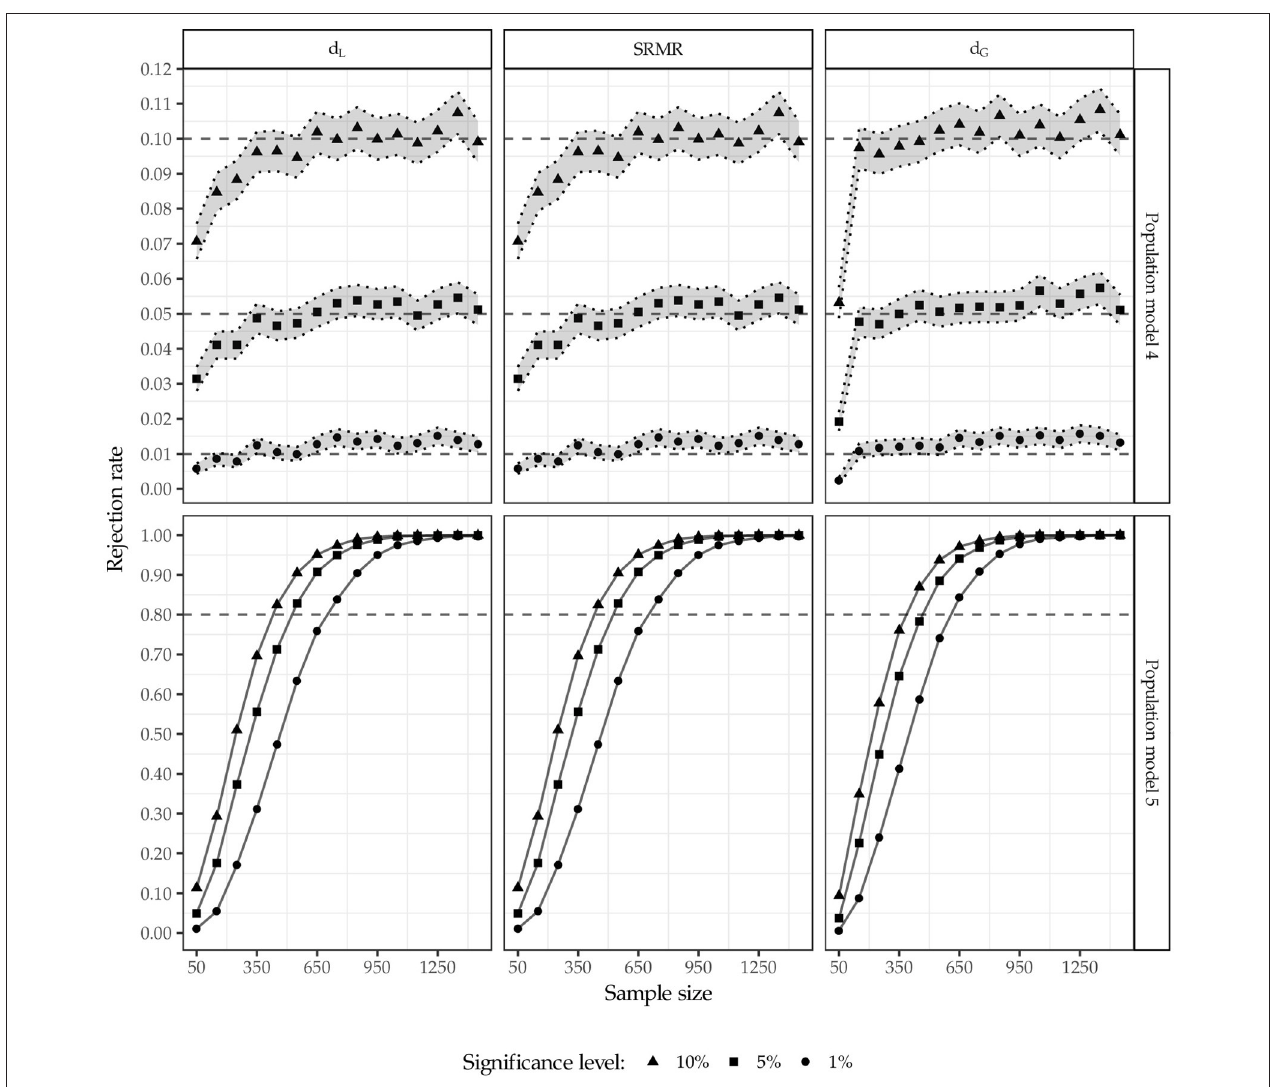
FIGURE 8 | Rejection rates for population model 4 and